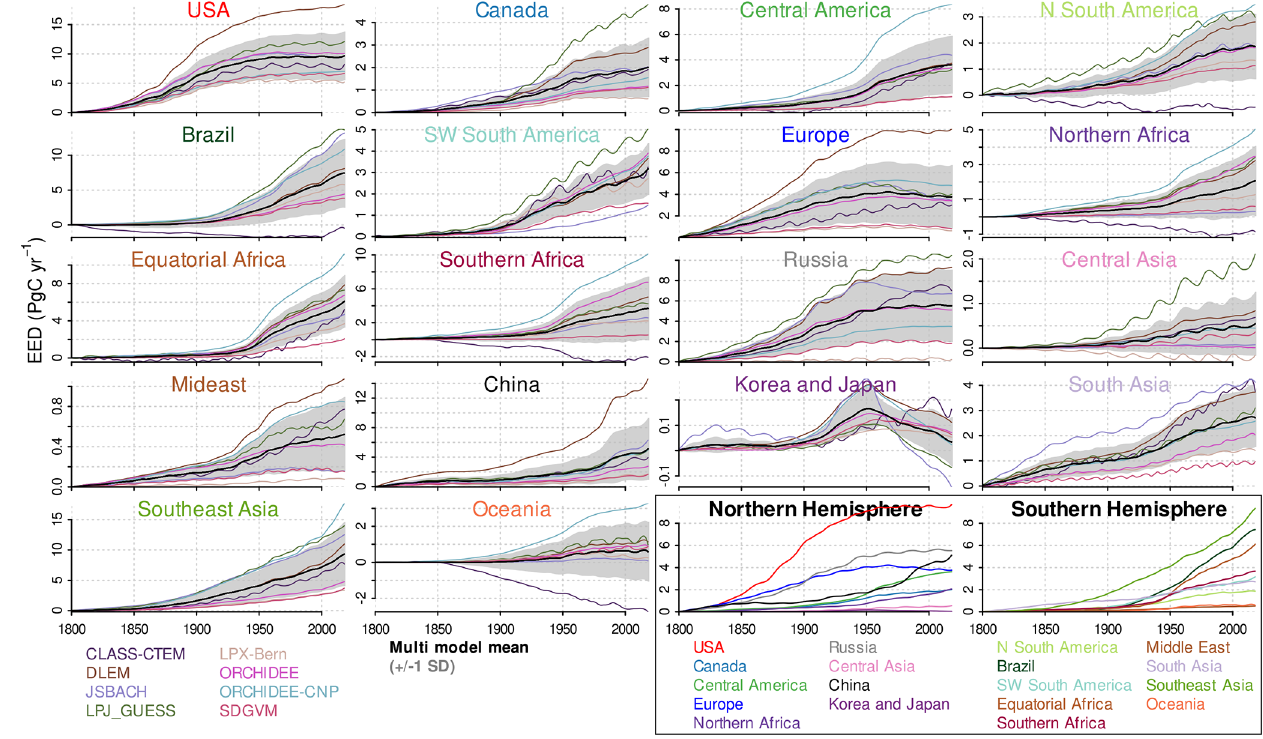
Figure A12. Region-wise smoothed cumulative difference between the f LULCC under present-day and pre-industrial environmental condi- tions (environmental equilibrium difference, EED) from 1800 onward (compare Eq. 6). EED was not derived for CLM5.0, JULES, LPJ, and OCN models (compare Table 2). For a discussion of individual models refer to Sect. A1. The last two panels show regional ensemble means on a uniform